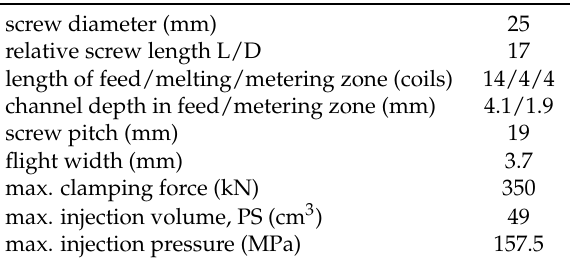
Table 1. Characteristics of the screw and the injection moulding machine.